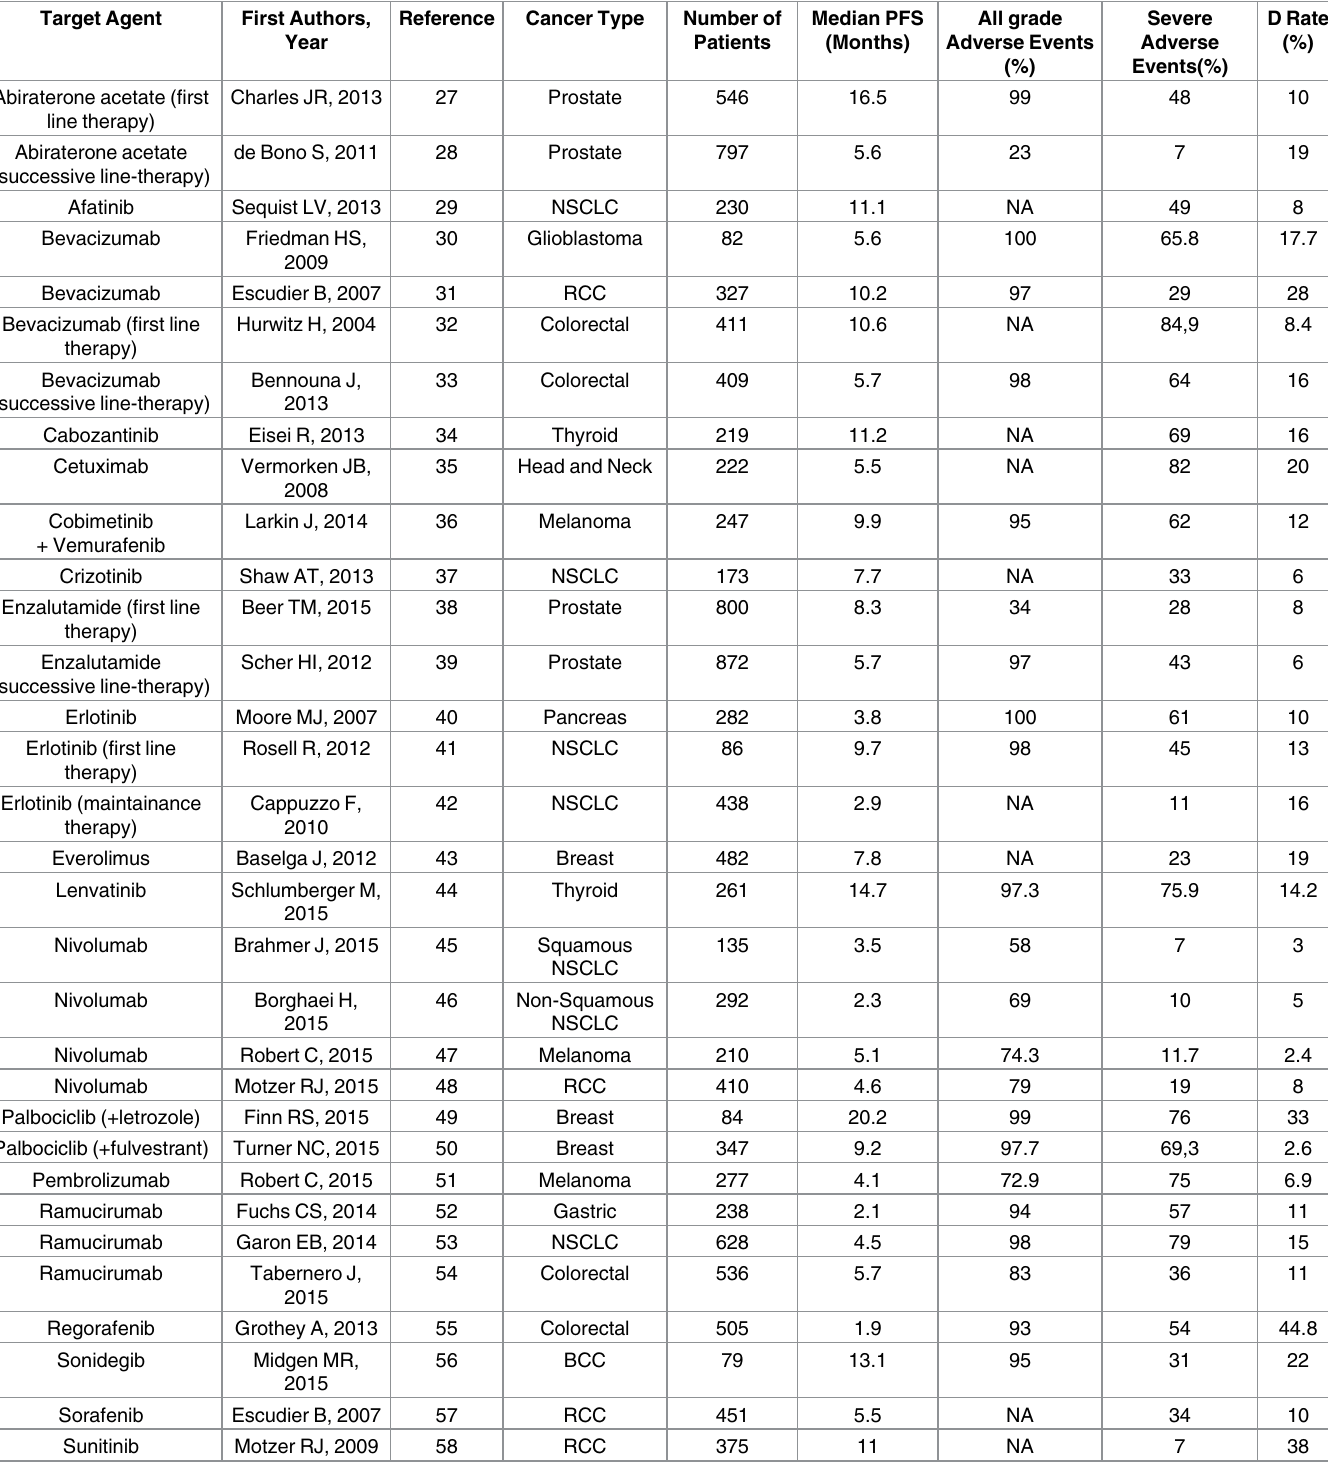
Table 1. List of target agents employed in oncological patients. Their characteristics are related to drug efficacy in terms of median Progression-Free Survival (PFS) and drug toxicity in terms of rate of all-grade,severe adverseevents and discontinuation rate. BCC =